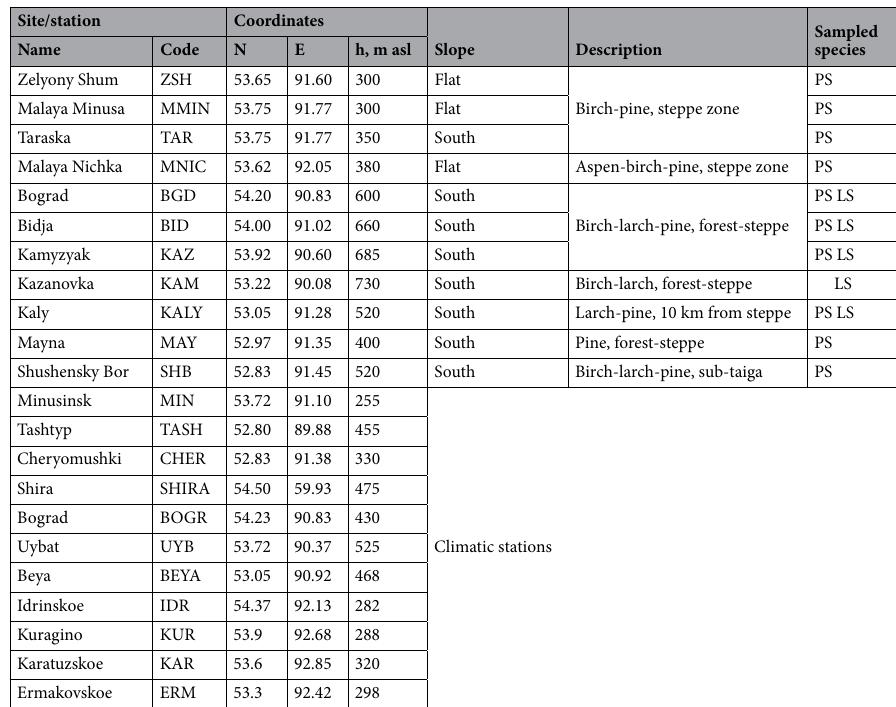
Table 1. Sampling sites and climatic stations. Sampled tree species encoded as PS— Pinus sylvestris L., LS— Larix sibirica